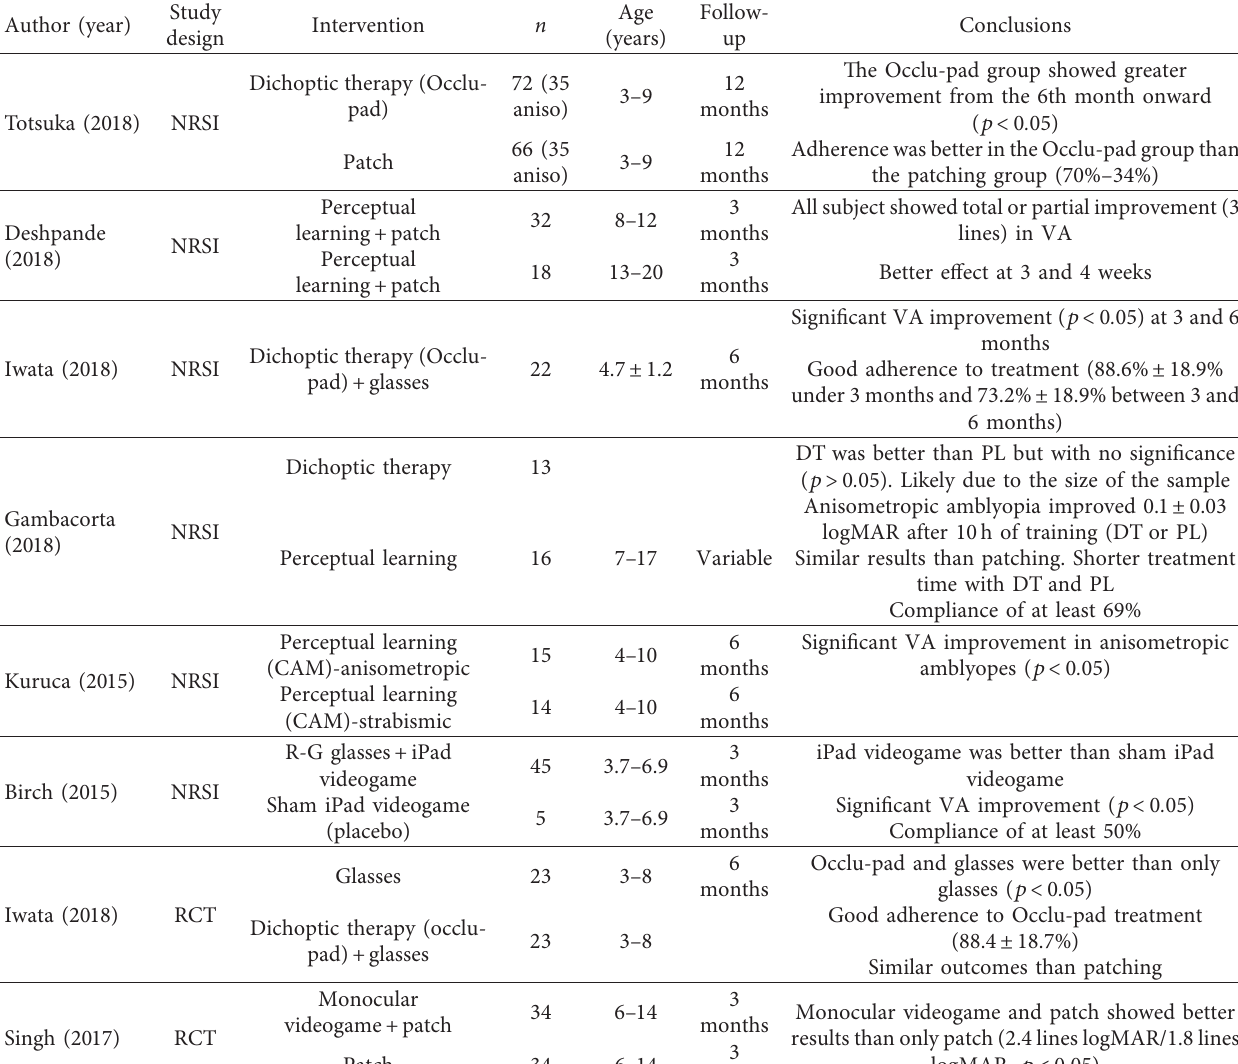
Table 2: Main aspect of the included studies.